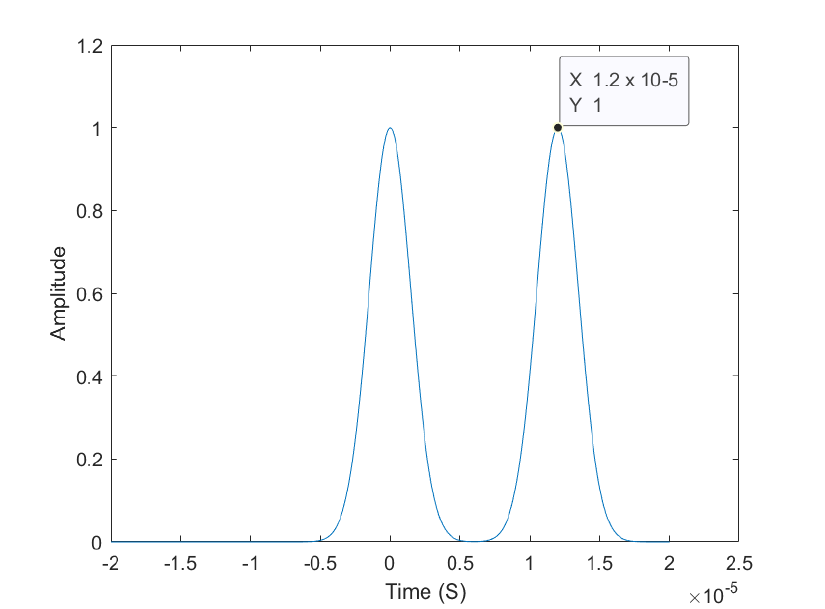
Figure 8. Standard DME pulse